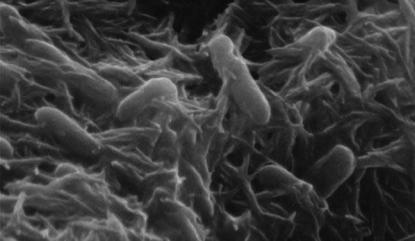
The bacterium
Shewanella oneidensis strain MR-1 (above) may offer a biological solution for remediating US sites contaminated during the manufacture of nuclear weapons.